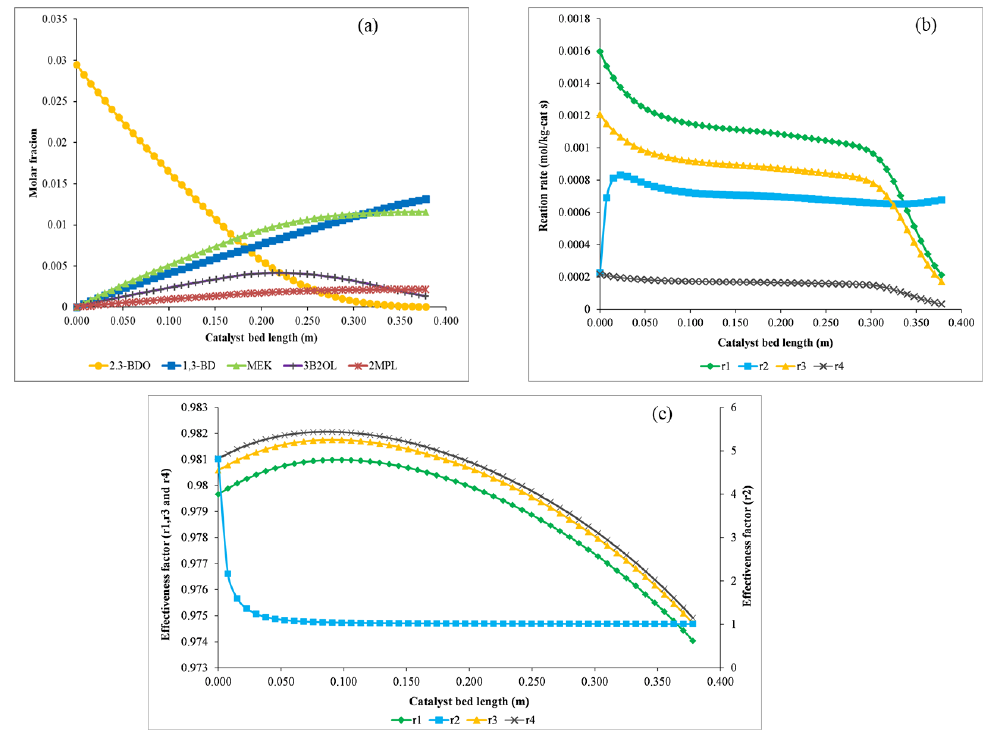
Figure 4. Profiles of the molar fractions of components ( a ), reaction rates ( b ), and effectiveness factors ( c ) along the length of the catalyst bed.